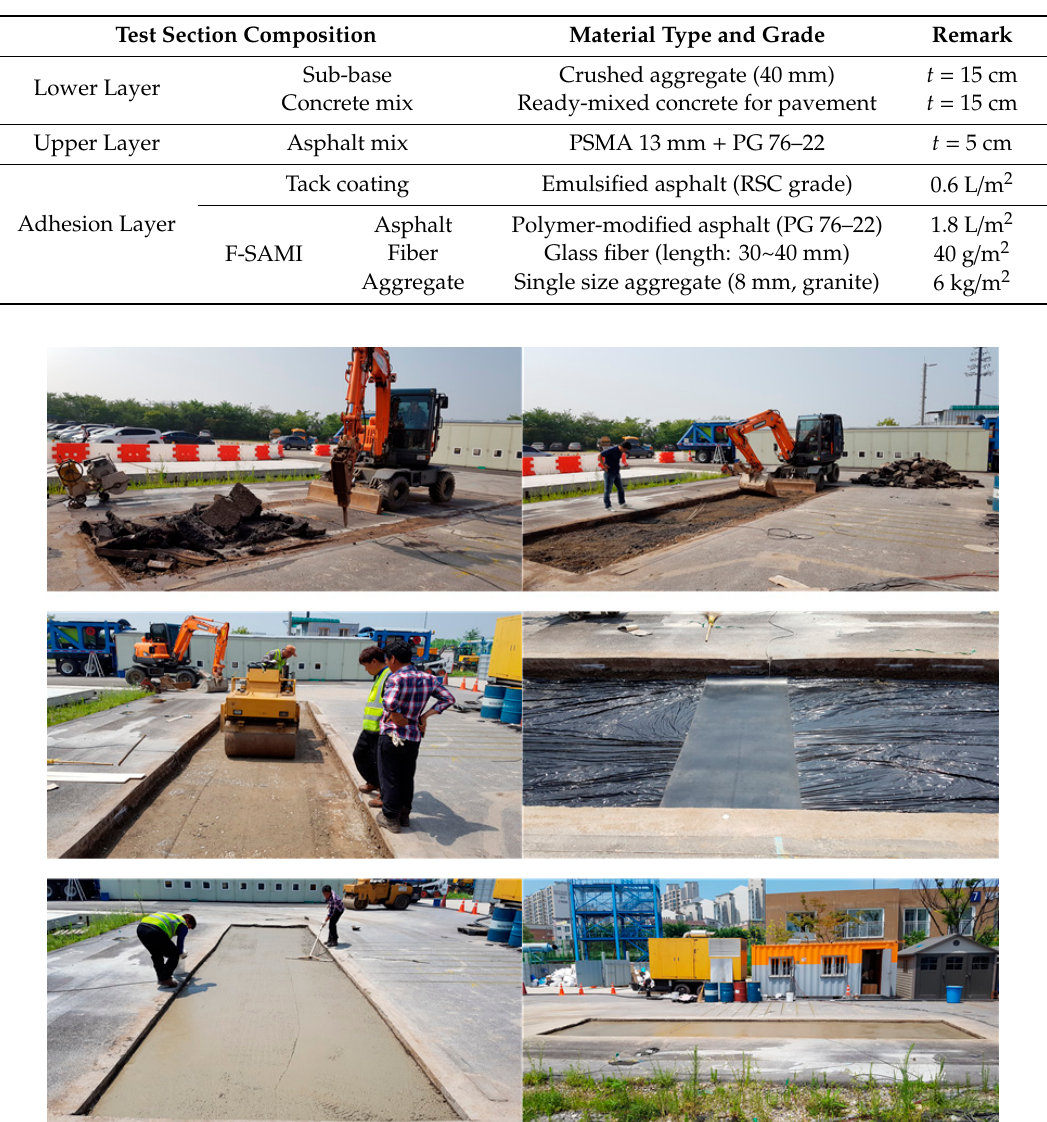
Figure 8. Construction for test section: lower layer.